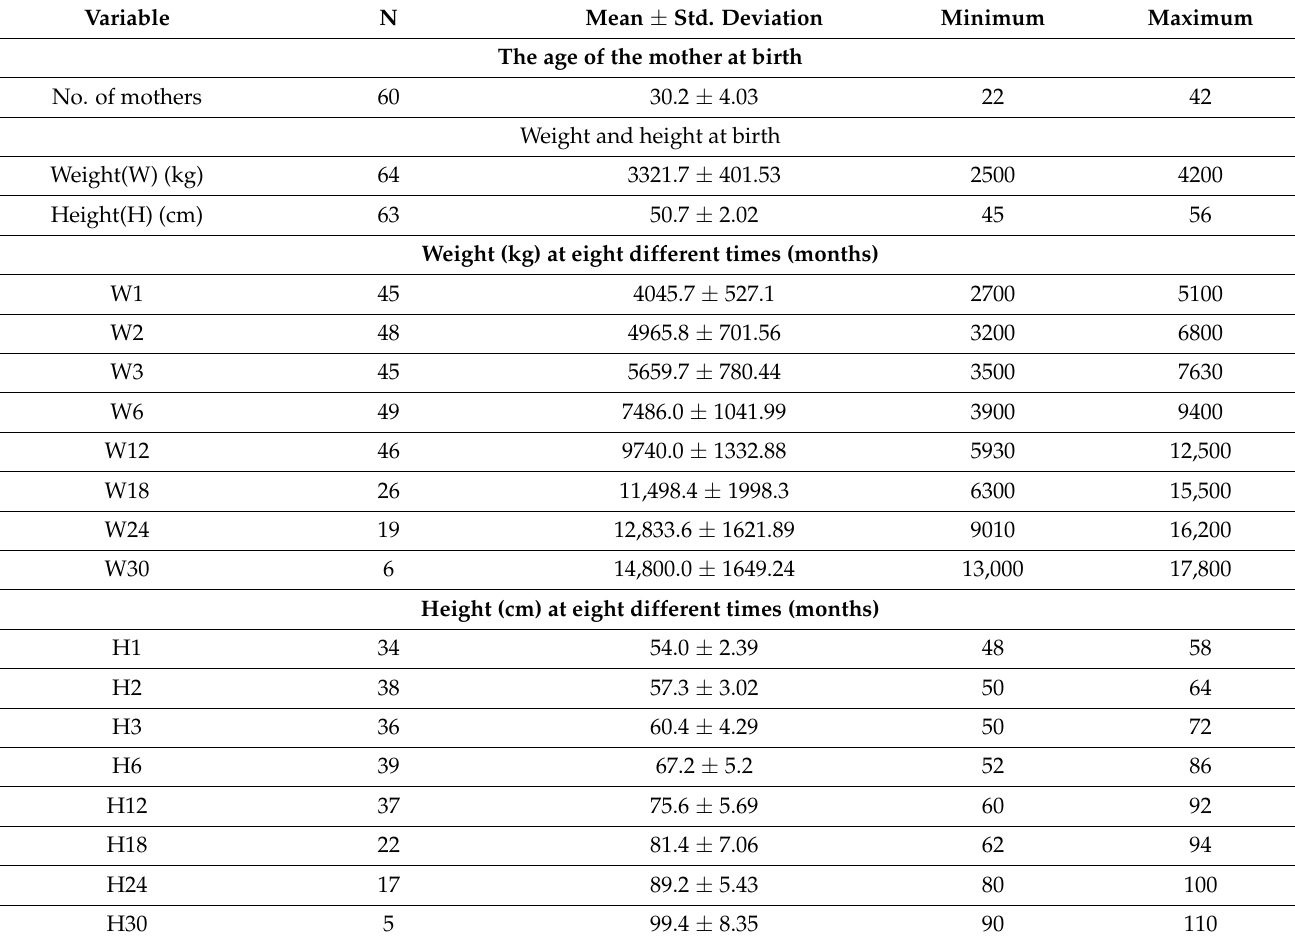
Table 1. Table of characteristics from birth to 30